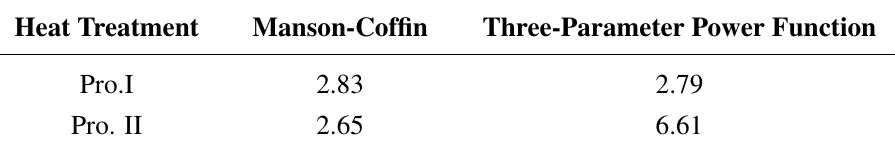
Table 2. Error analysis of life prediction (%).